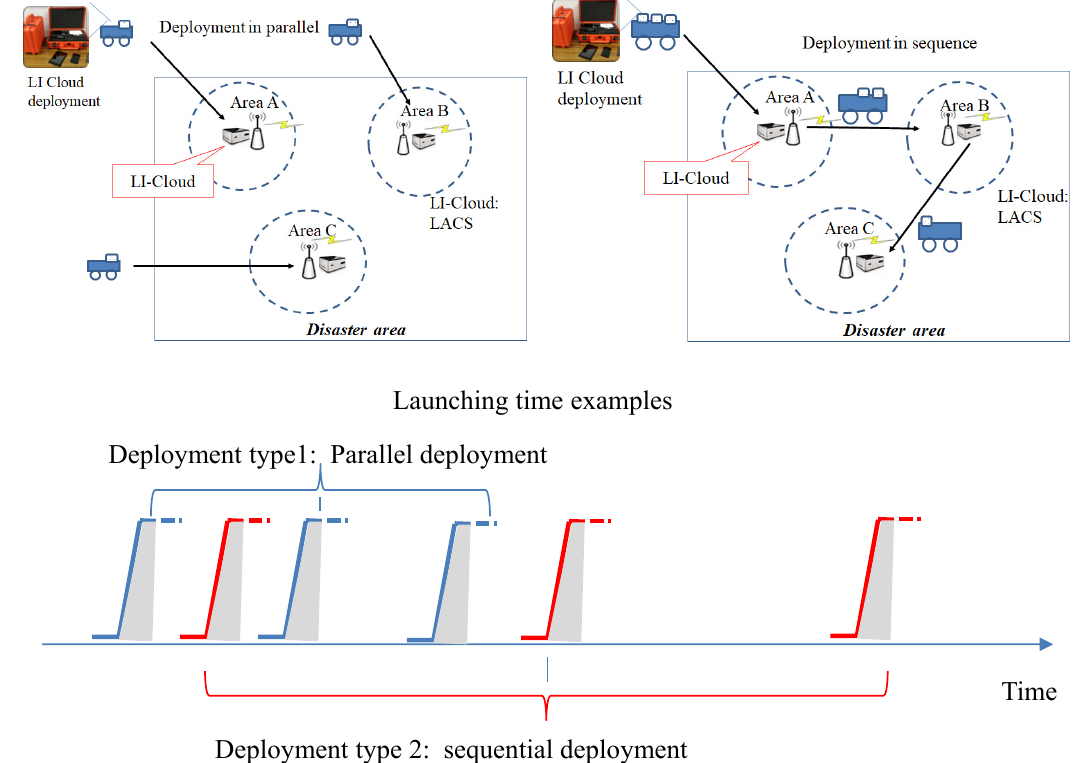
Figure 3. Two types of launching time